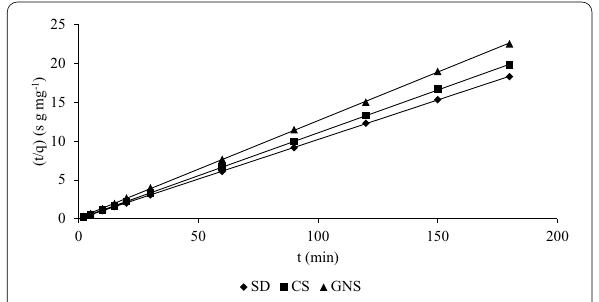
Fig. 11 Plot of ( t / q ) vs t for 1 g SD, CS and GNS at 30 °C